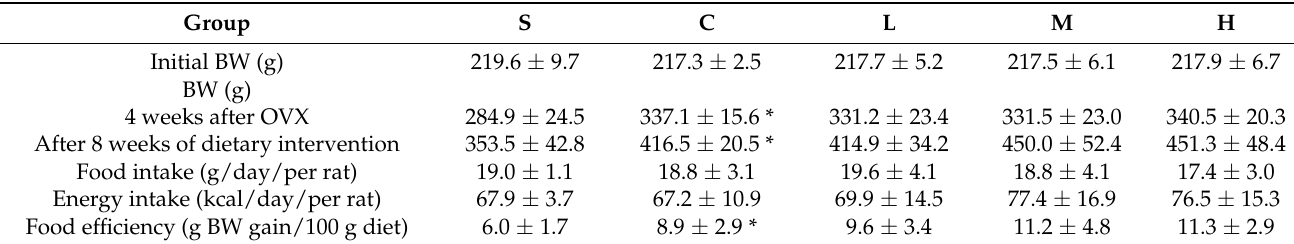
Table 4. Body weight (BW), food intake variables of SD rats after an ovariectomy (OVX) and 8 weeks of a dietary